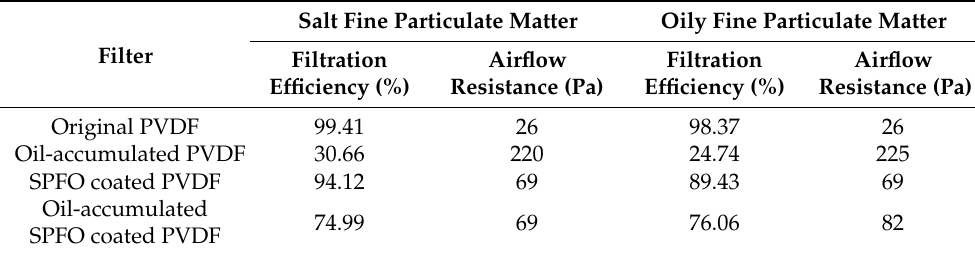
Table 1. The filtration efficiency and airflow resistance of PVDF filters at 32 L/min airflow.